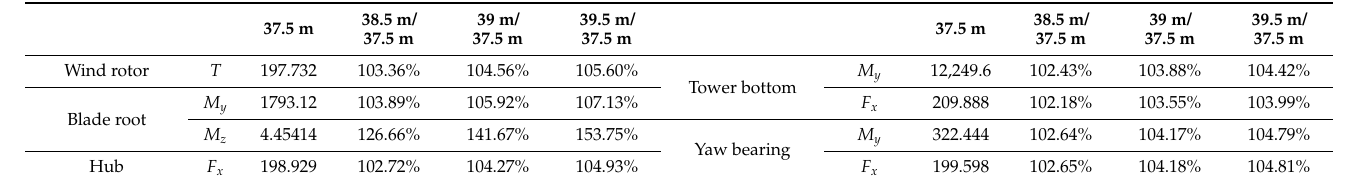
Table 5. Comparison of the steady loads of wind turbines with different blade lengths.